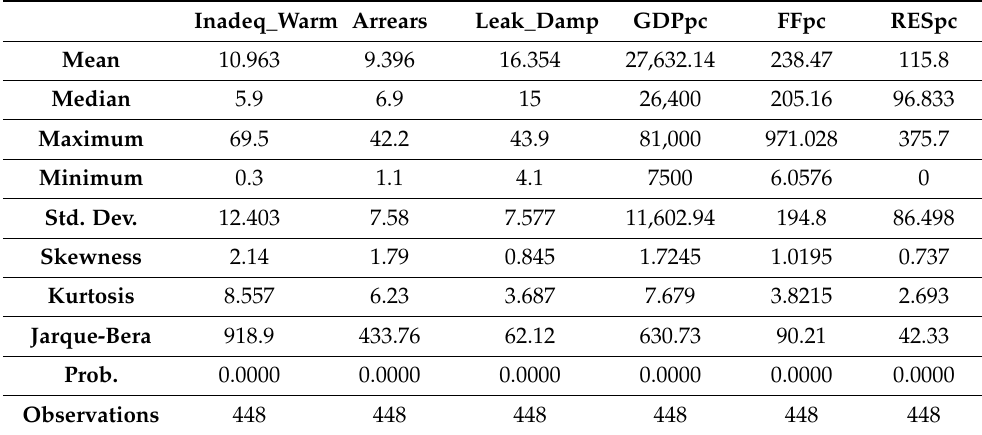
Table 2. Descriptive Statistics of used indicators.